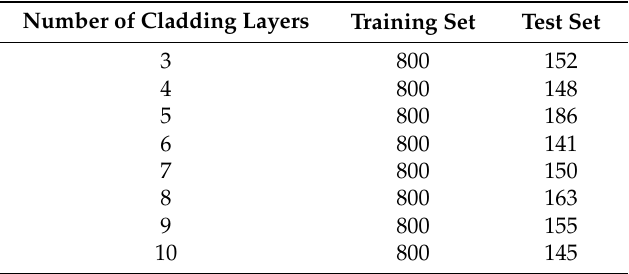
Table 6. Number of data groups within training and test sets.